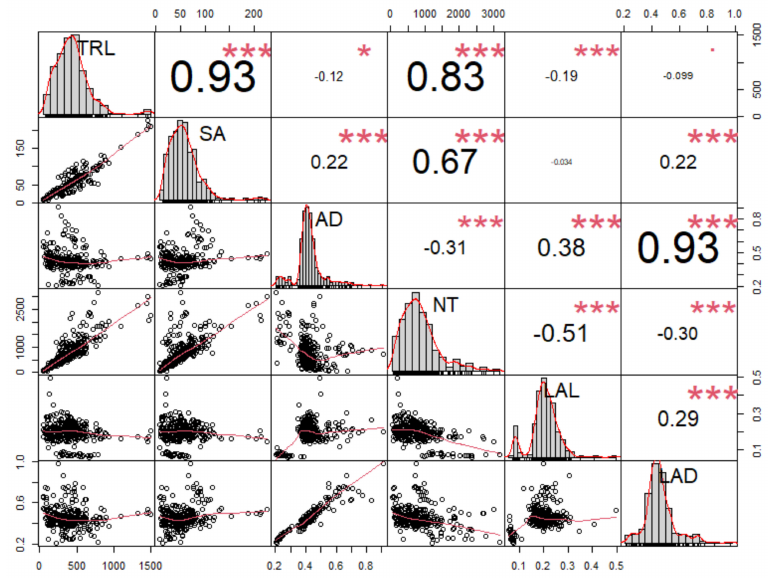
Figure 5. Correlation analysis between six root traits (TRL, SA, AD, NT, LAL, and LAD) in 61 adzuki bean wild accessions examined 35 days after planting at the second or third trifoliate leaf stage. Abbreviations: TRL, total root length; SA, surface area; AD, average diameter; NT, number of tips; LAL, link average length; LAD, link average diameter. In the figure, asterisks (*) represent significance at the 0.05 level; p ≤ 0.01 (*), p ≤ 0.001 (**), and p ≤ 0.0001